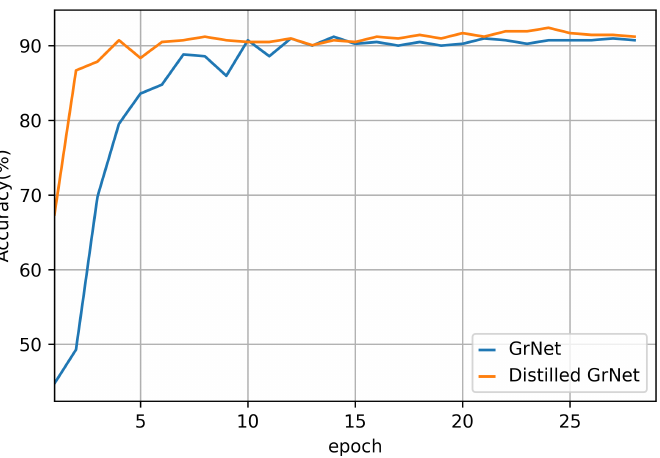
Figure 9. Convergence rate comparison between GrNet and Distilled